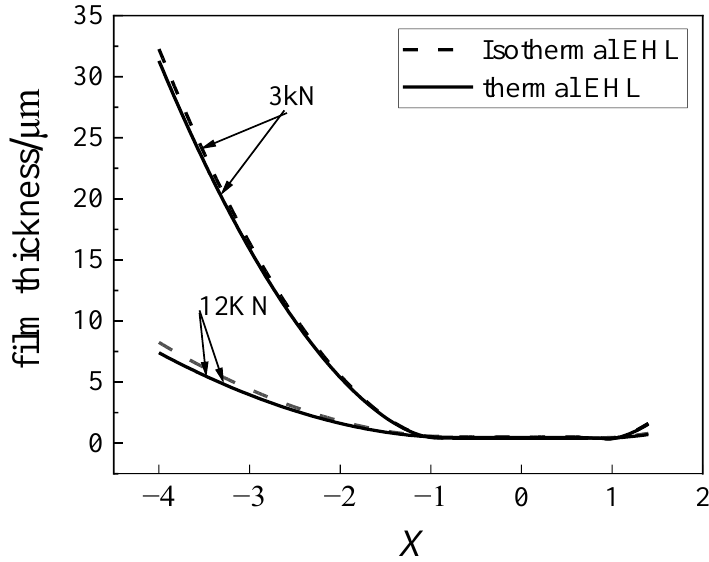
Figure 3. Effect of radial load on film thickness distribution.